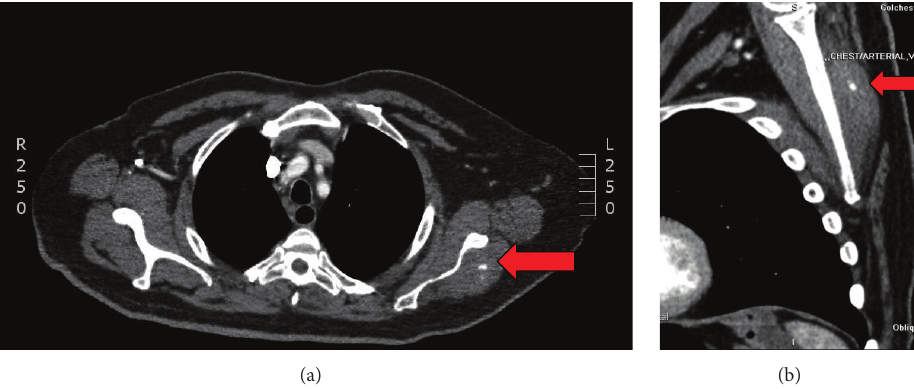
Figure 2: Axial and oblique CT scan, respectively, demonstrating lesion within the left infraspinatus muscle (arrow). Area of central calcification